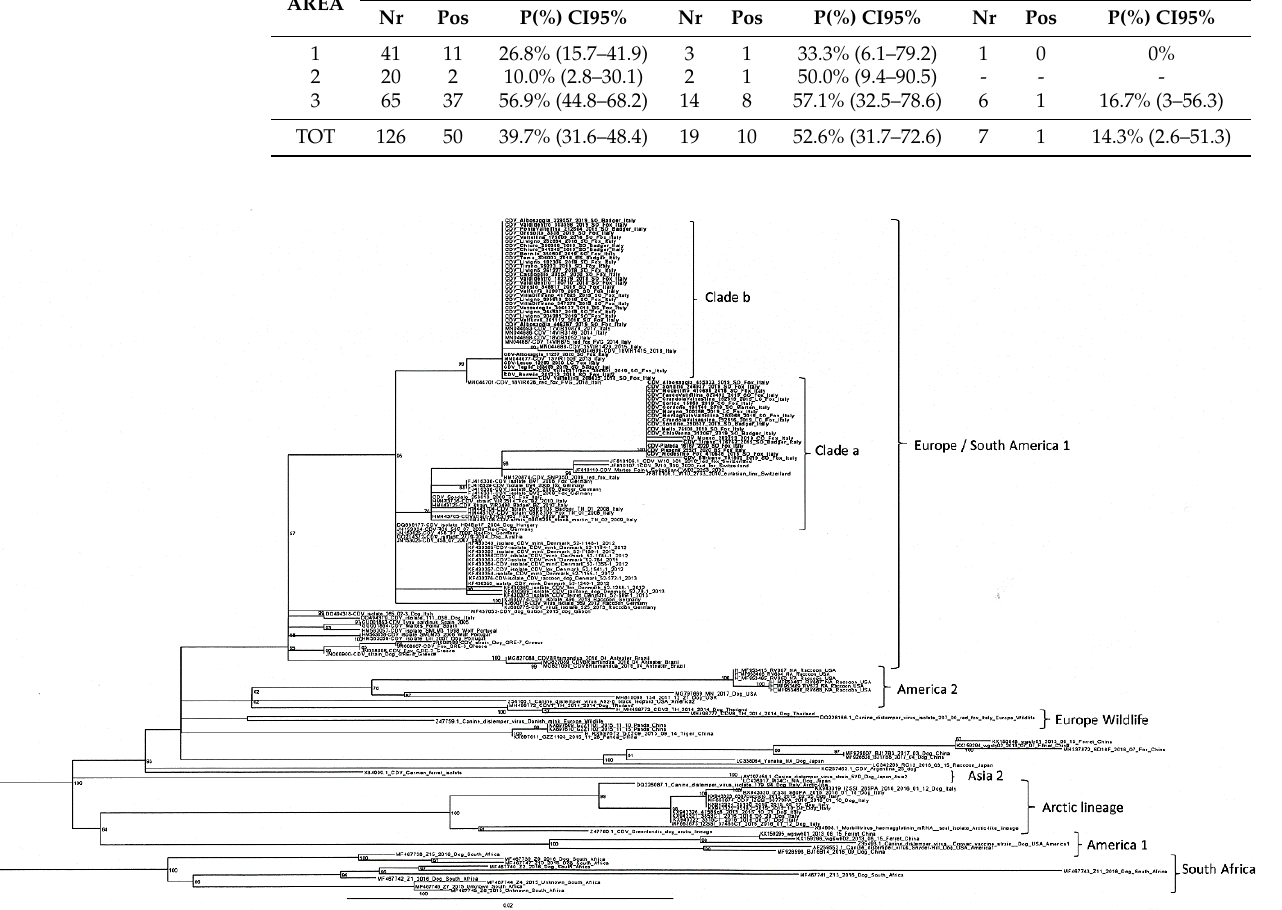
Figure 3. Maximum-likelihood phylogenetic tree based on the partial sequencing of the H gene. Italian CDV sequences investigated in this study are reported in bold. Reference CDV sequences are named, including the genBank accession number, the name of the strain, the host, and the country of origin. Boostrap values are indicated next to nodes.